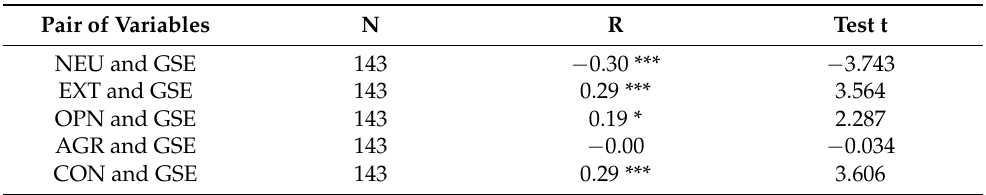
Table 4. Spearman’s rank correlation between general self-efficacy and personality traits intensity measured with NEO-FFI in sten